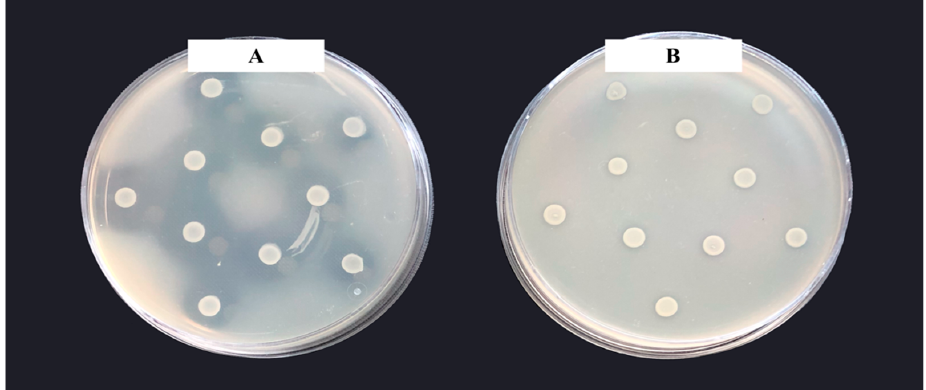
Figure 1. Inhibition zones in E. coli agar overlaid with wildtype Z. mobilis Zm6 ( A ) and its respiratory mutant derivative Zm6- ndh ( B ). Table 1. Inhibition zones in E. coli agar overlays with several Z. mobilis strains.